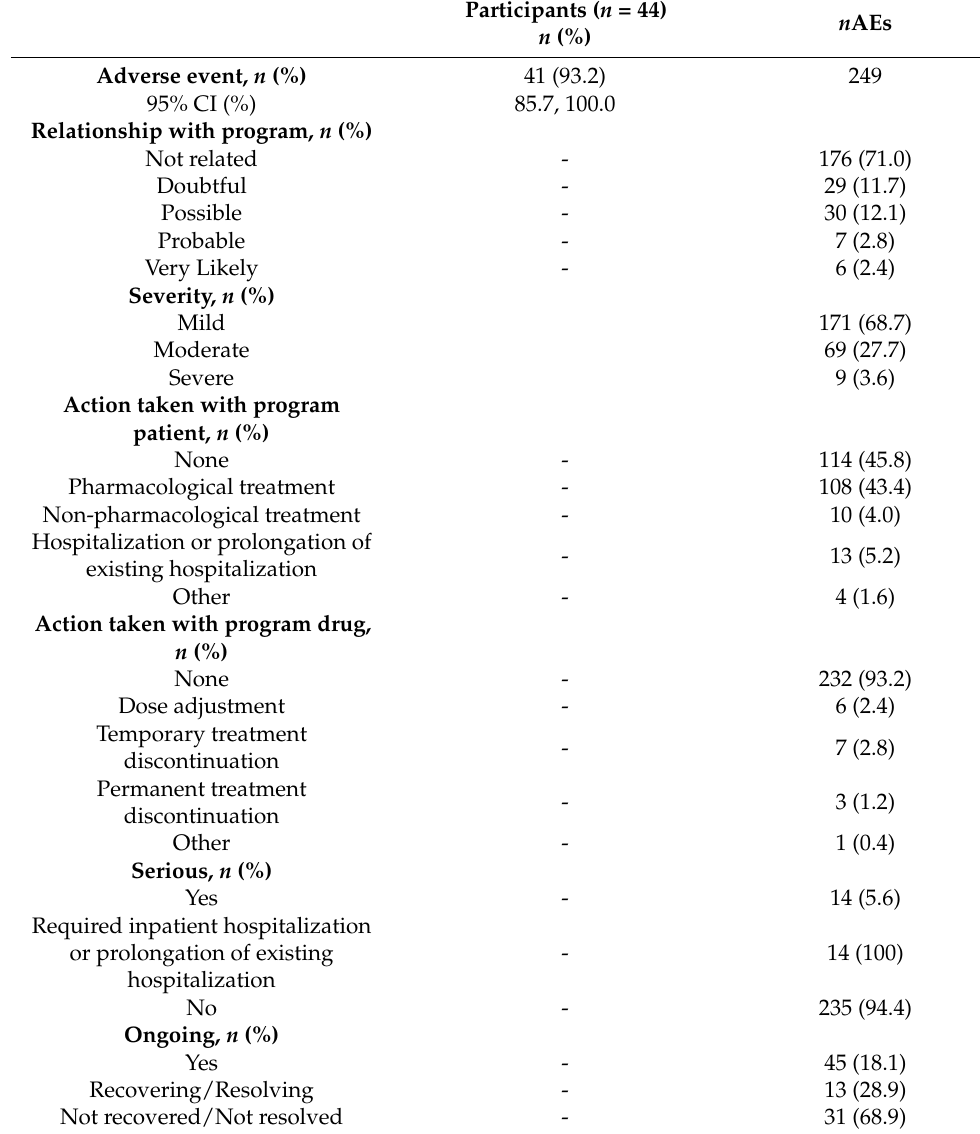
Table 2. Overall adverse event